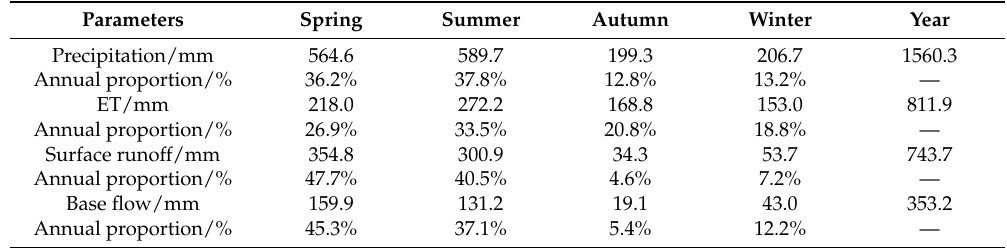
Table 1. Seasonal distribution of precipitation, ET, surface runoff and base flow in Pengchongjian small watershed from 1983 to